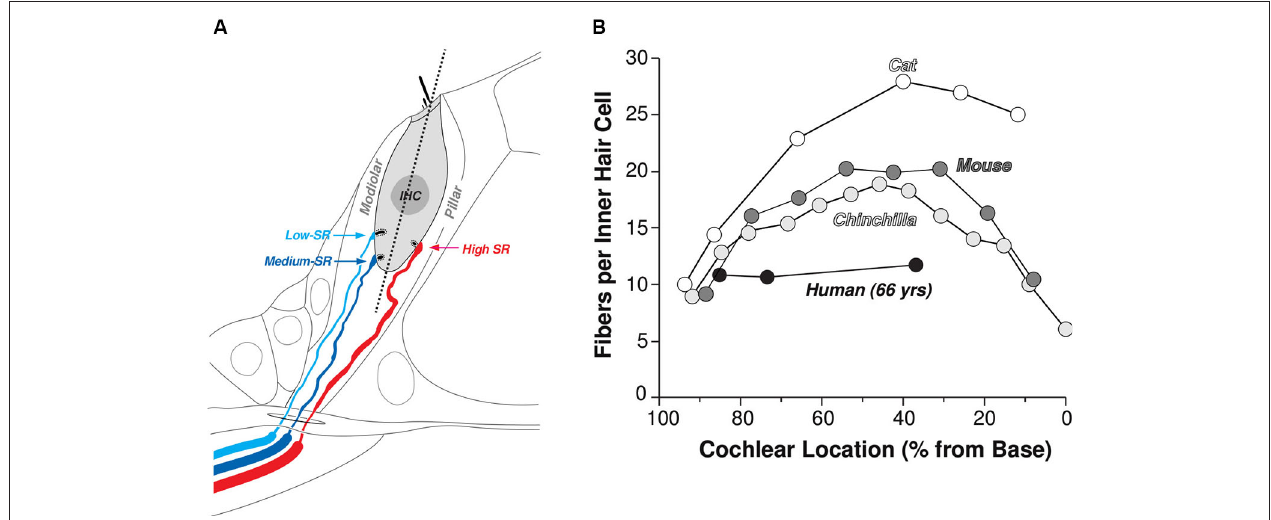
Counts of cochlear nerve terminals per IHCs as a function of cochlear location from four mammalian species: cat (Liberman et al., 1990), mouse (Maison et al., 2013), chinchilla (Bohne et al., 1982) and human (Nadol,